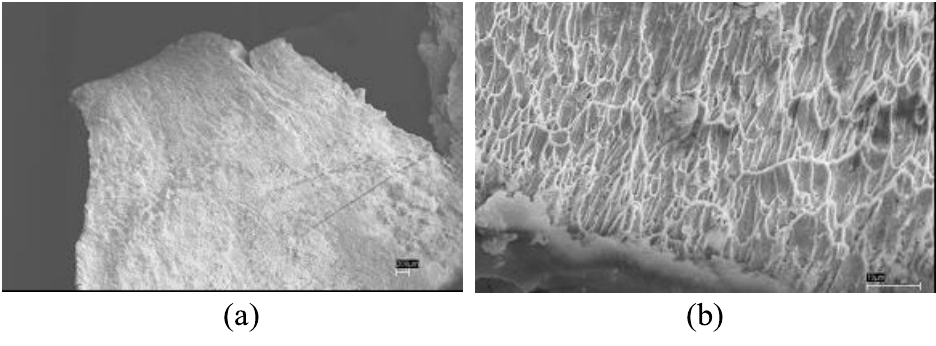
Fig. 8. Fracture surfaces from a plate displaying local holing and petaling damage: a) thinning, b) void coalescence. damage modes can be related to the loading by examining the damage as a function of the standoff for a given charge size. Standoff regimes for plate failure can thus be identified as follows for increasing standoff